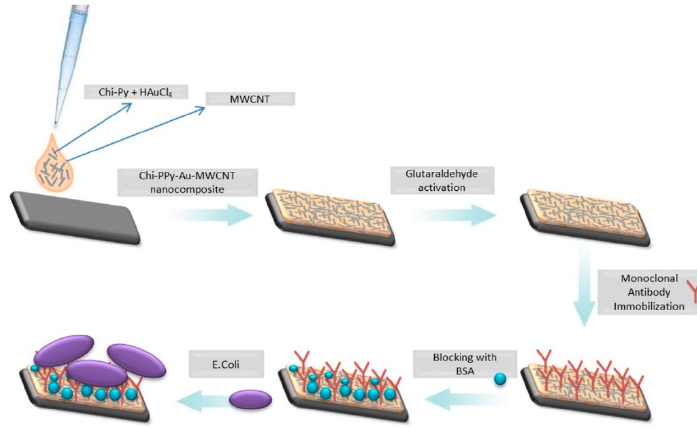
Figure 5. Schematic illustration of the experimental setup of the immunosensor [77] .